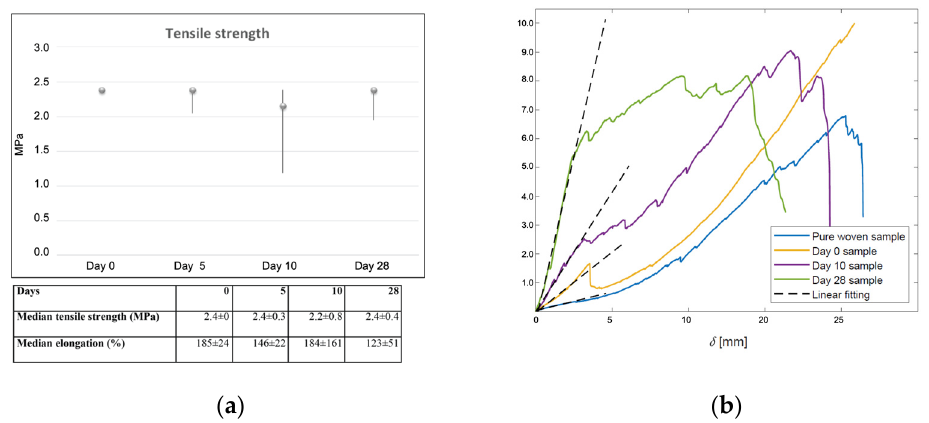
Figure 6. Tensile strength and elongation of transplants. ( a ) Measured tensile strength (median and variation) of 3D PC scaffolds, at different integration time points are plotted in the diagram (maximum measurable strength was 2.4 MPa). Corresponding median strength and relative elongation at different time points in the table below. ( b ) Elasticity demonstrated as load-displacement curves from tensile tests and the corresponding linear curve fitting results. The stiffness, indicated by the inclination of the fitted dash lines, were 0.13 N/mm (control), 0.42 N/mm (0 days), 0.83 N/mm (10 days) and 2.30 N/mm (28